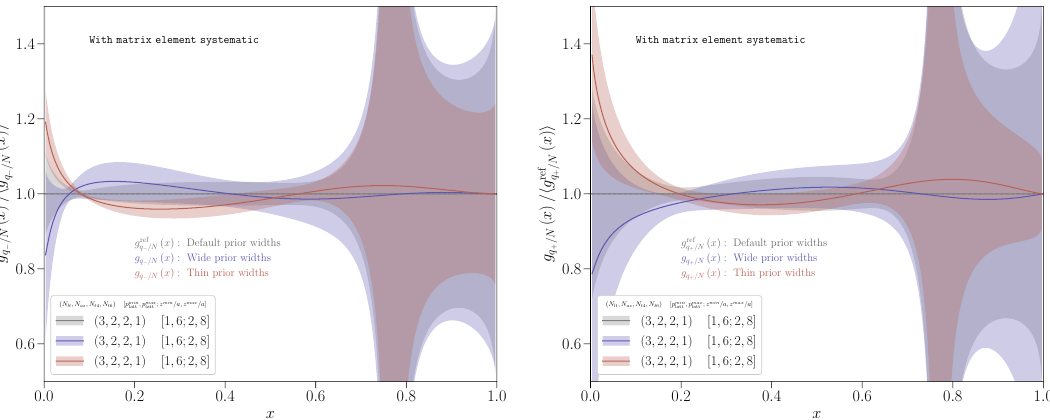
Figure 14 . Variability of extracted (left) g prior widths of the model ( N lt , N az , N t 4 , N t 6 ) = (3 , 2 , 2 , 1) fit to Y z/a ∈ [2 , 8] , are doubled and halved. The matrix element fitting systematic is included for this